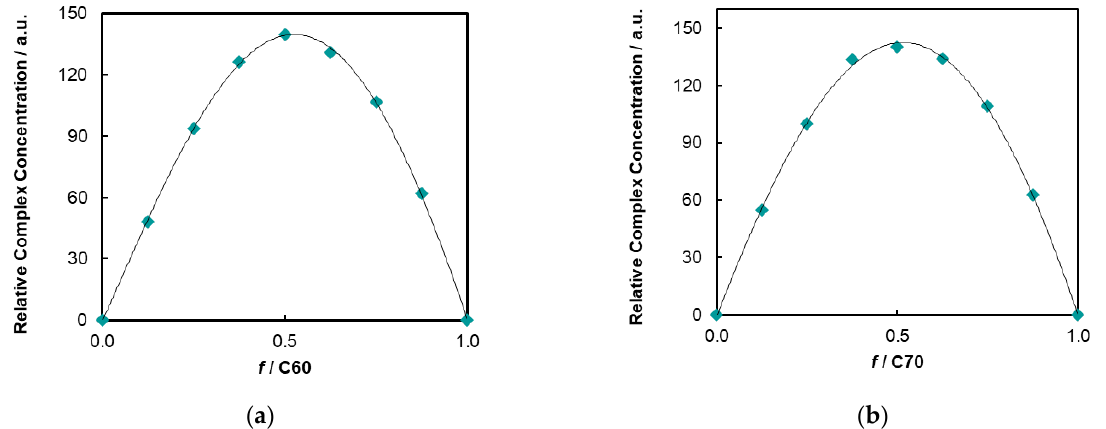
Figure 7. Job plot for complex formation between bis-calixarene-3,6-CBZ ( 4 ) and C 60 ( a ) C 70 ( b ) in toluene (at constant 6.0 × 10 − 7 M total concentration) as obtained from changes in fluorescence ( λ exc = 357 nm).